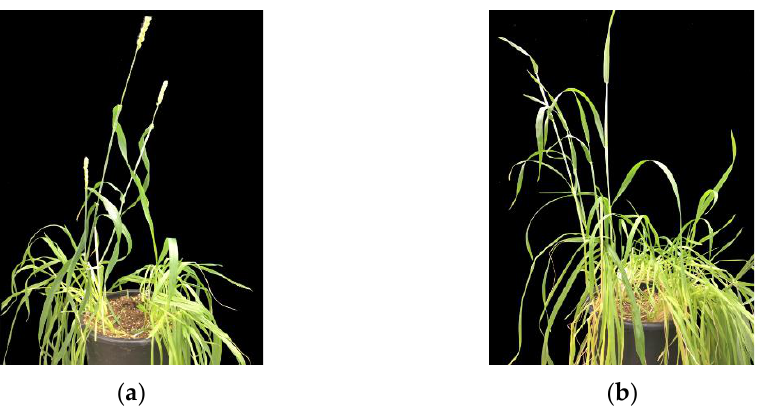
Figure 5. Plants of CASL7BS and CS under different vernalization and photoperiod conditions. ( a ): No vernalization and grown under LD; ( b ): vernalization for 20 days and grown under short day. Two plants of CASL7BS ( left ) and CS ( right ) were planted in the same pot.